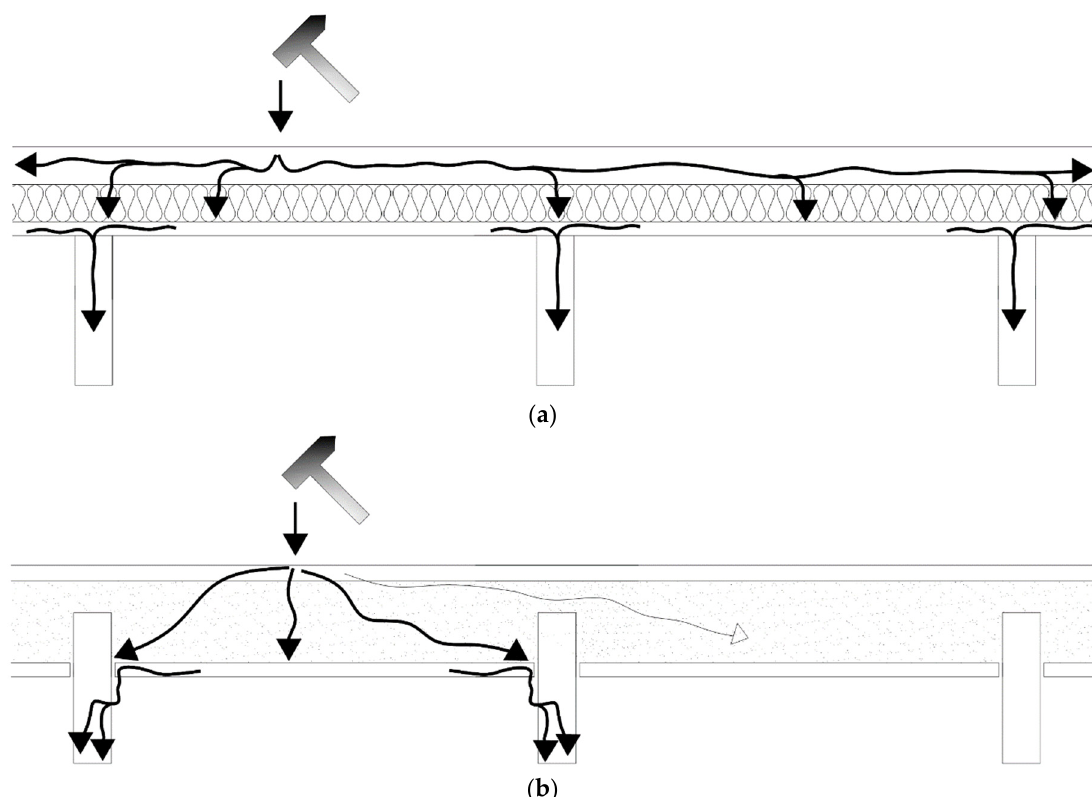
Figure 9. Structural paths of sound transmission in the case of: ( a ) Heavy floating floor with a concrete slab on the top; ( b ) Lightweight floating floor built with dry-screed boards and expanded clay aggregate.